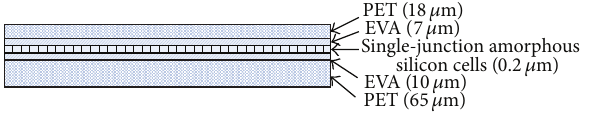
Figure 3: Structure of flexible thin-film solar